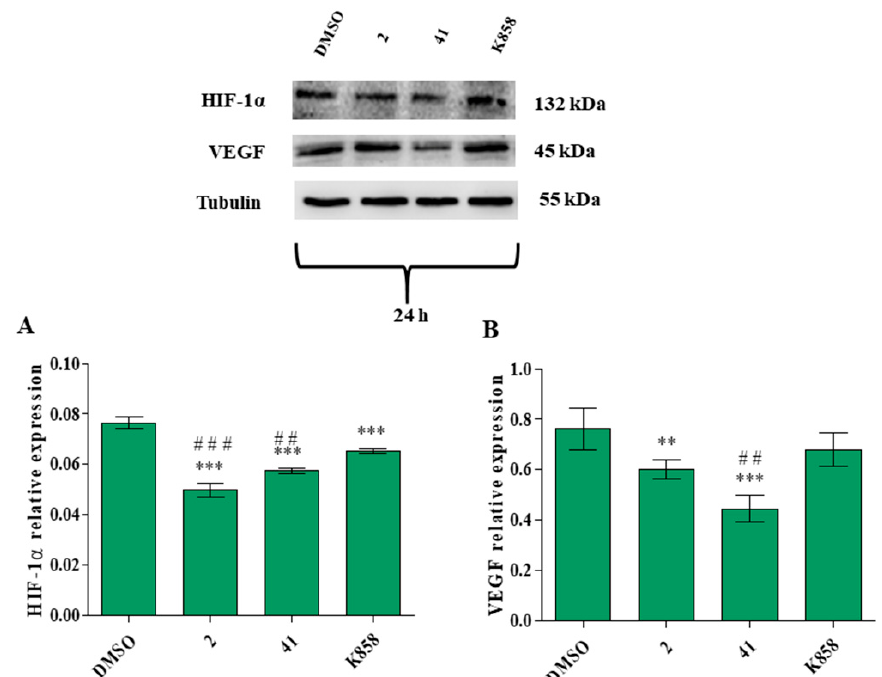
Figure 10. Hypoxia inducible factor 1 α (HIF-1 α ) ( A ) and vascular endothelial growth factor (VEGF) ( B ) protein expression levels in MCF7 cell line treated with 2 (1.5 µ M), 41 (5 µ M) and K858 (10 µ M) for 24 h. DMSO: control vehicle. Data are reported as means ± SD of three independent experiments. Tubulin is used as a loading control. The bar graph displays densitometric values normalized on loading control. ( A ): *** p < 0.0001 DMSO vs. Eg5 inhibitors; ### p < 0.0001 K858 vs. 2 and 41; ## p < 0.001 K858 vs. 2 and 41. ( B ): *** p < 0.0002 DMSO vs. Eg5 inhibitors; ** p < 0.002 DMSO vs. Eg5 inhibitors; ## p < 0.002 K858 vs. 2 and 41.